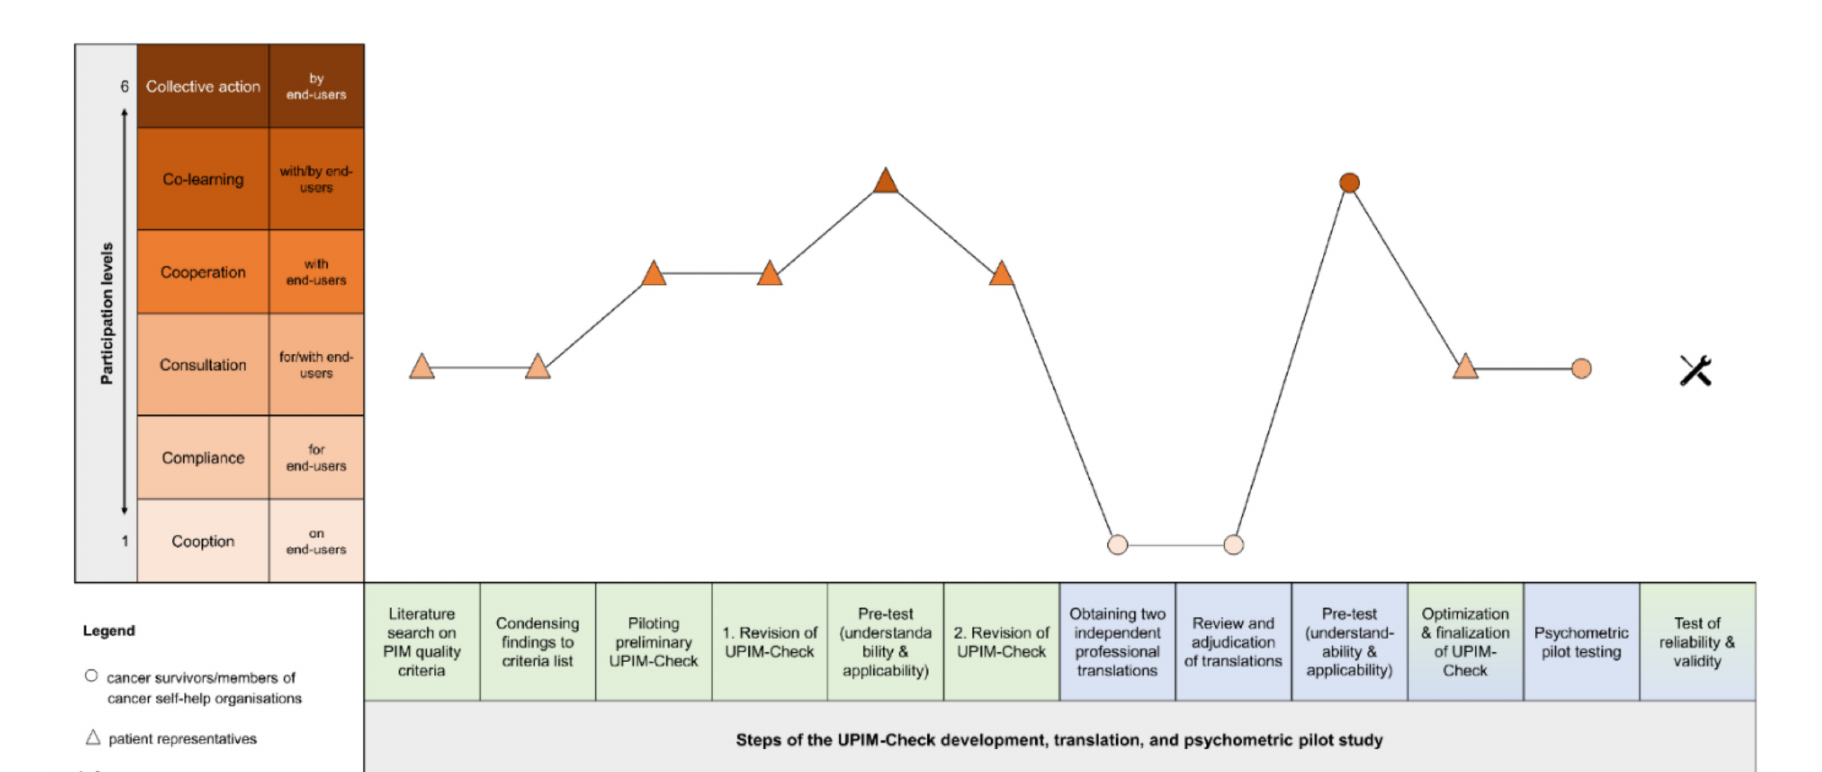
Figure 4. Levels of end-users’ participation (according to Cornwall (1996)) within the steps of the UPIM-Check development and translation process and psychometric pilot